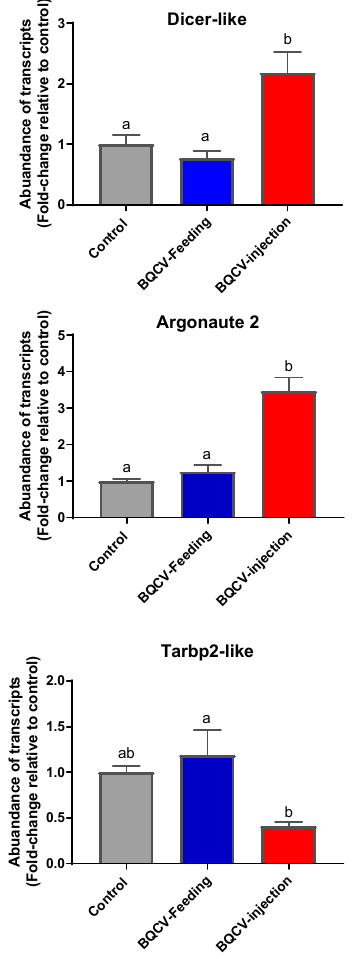
Figure 3. Fold-change (mean ± SE) of transcripts of three innate immune pathway genes in adult honey bees at 10 days post BQCV inoculation. Bees ( n = 6 bees per treatment) were either injected with one µ L inoculum containing 10 8 BQCV or fed 10 µ L of sugar syrup containing 10 8 BQCV. Controls received the same treatments devoid of virus. Di ff erent lower case letters indicate statistically significant di ff erences between treatments (one-way ANOVA with Tukey’s post-hoc test, p < 0.05).